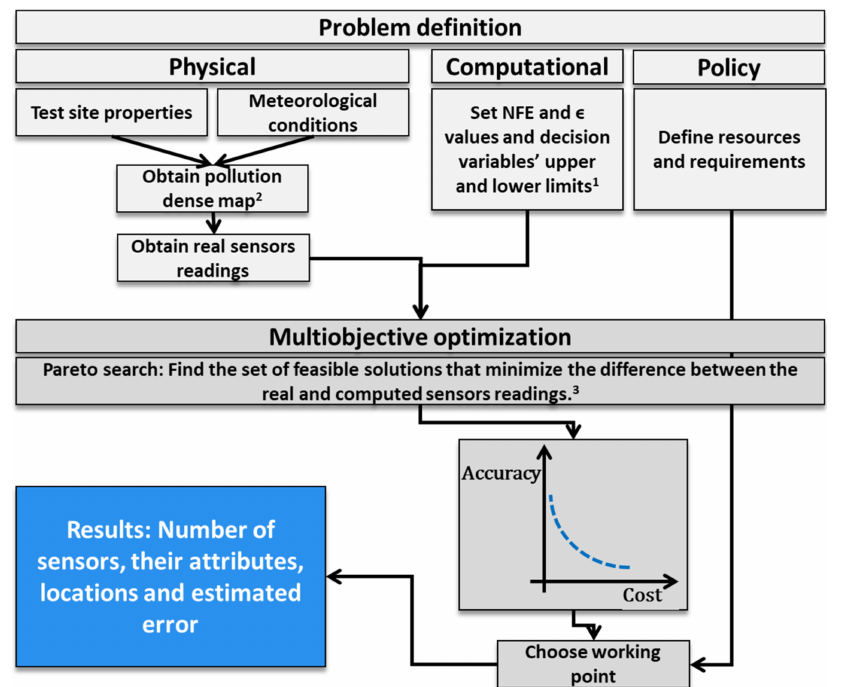
Figure 2. Flowchart of the method. 1. The decision variables are listed in Table 1 below. 2. Here, the pollution-dense map was obtained using the Lagrangian atmospheric dispersion model. 3. During the optimization, the sensors’ readings are computed using the same model based on assumed leak rates and sensor attributes (decision variables). If the assumed leak rate is close to the actual one and the sensor locations and attributes are optimal, the difference between the computed and the real sensors’ reading will be